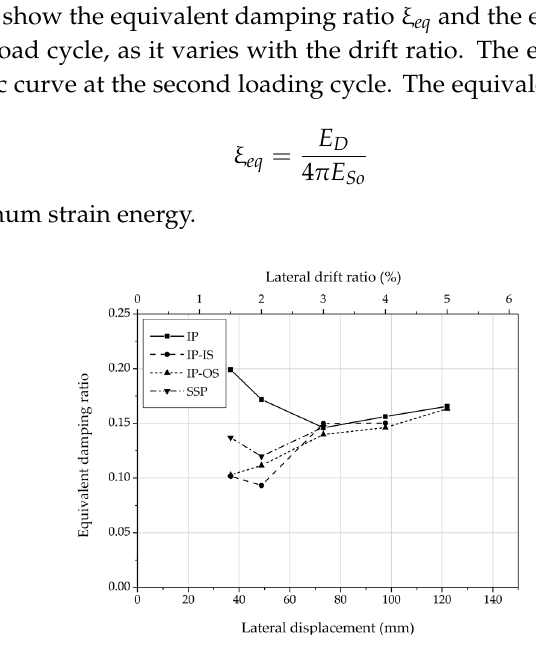
Figure 10. Variation in the equivalent damping ratio per load cycle with drift ratio.